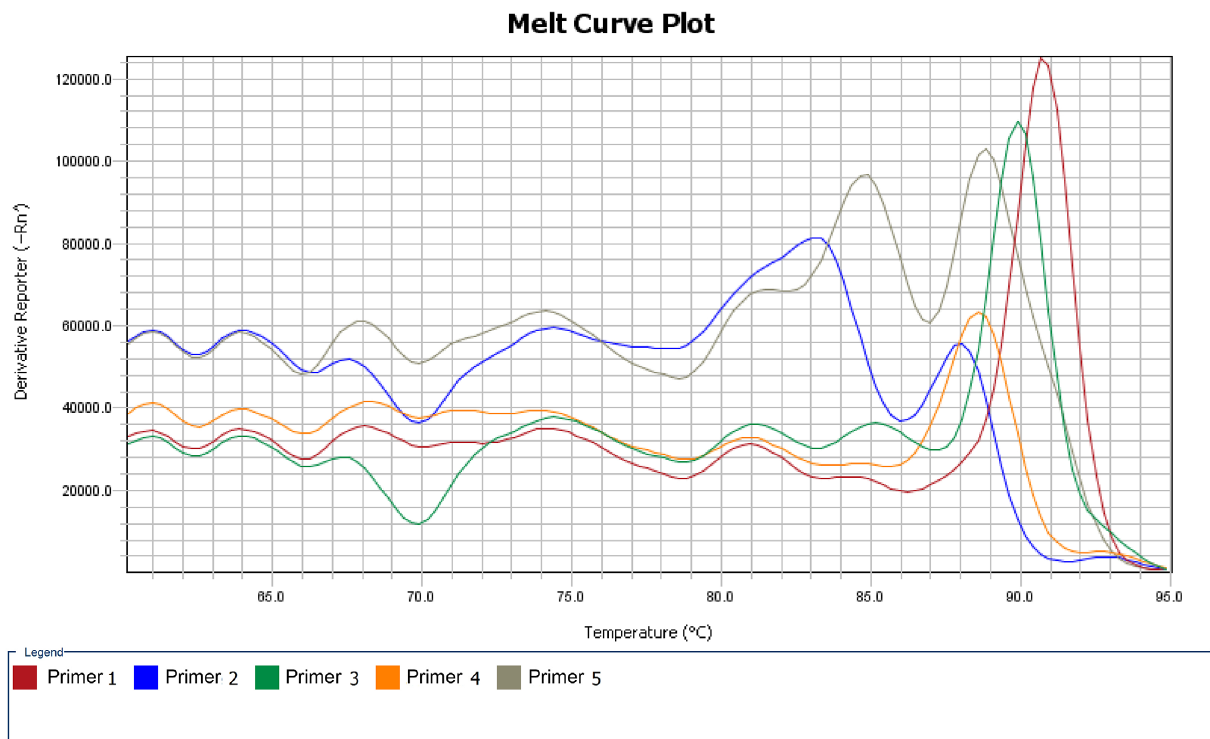
Figure 3. Melting curves for the fi ve primer pairs. Primer pairs 1 and 3 had a single high peak, and were highly speci fi cally ampli fi ed. Impure peaks developed in primer pairs 2 and 5, resulting in nonspeci fi c ampli fi cation. Primer 4 had a single low peak, indicating poor ampli fi cation ef fi ciency.